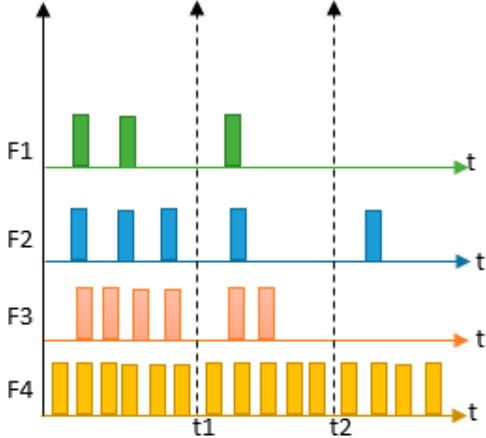
Figure 1. Example of flow with Figure 1 Example of flow with variabilities